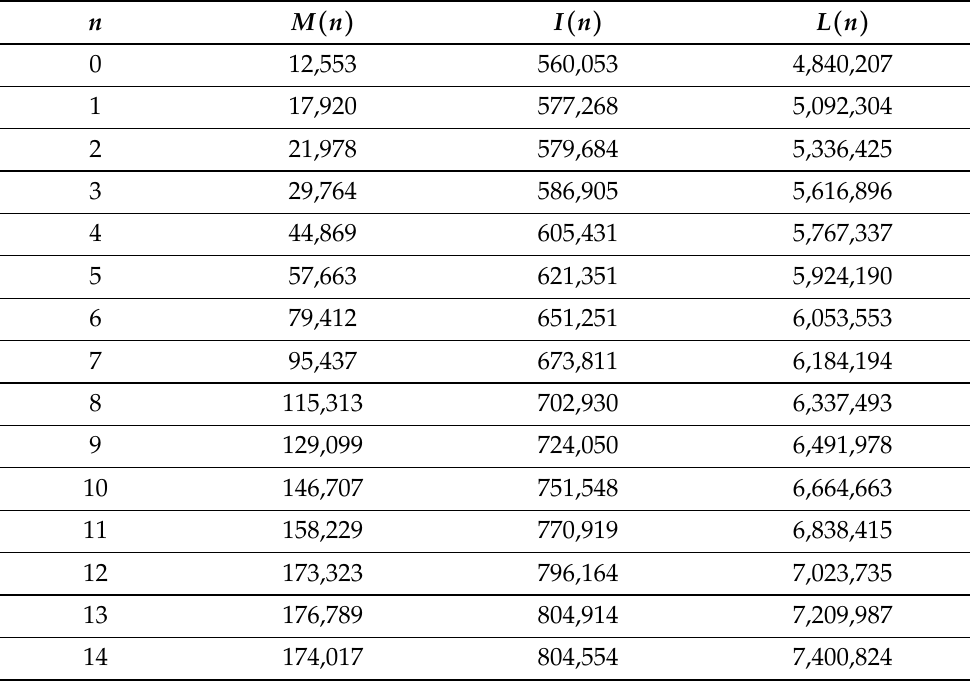
Table 4. Subpopulations in the studied period.